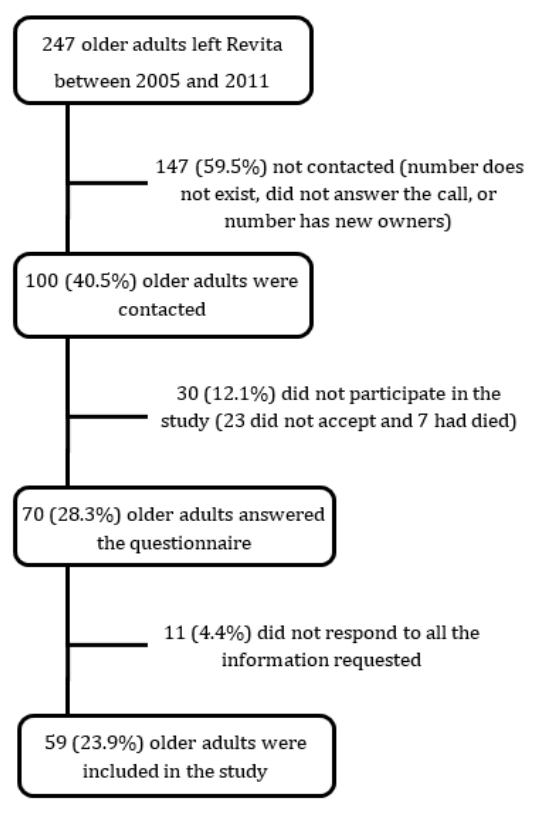
Figure 1 - Flowchart with the steps of the study: identifica- tion of older adults who dropped out, telephone contact, and application of the structured